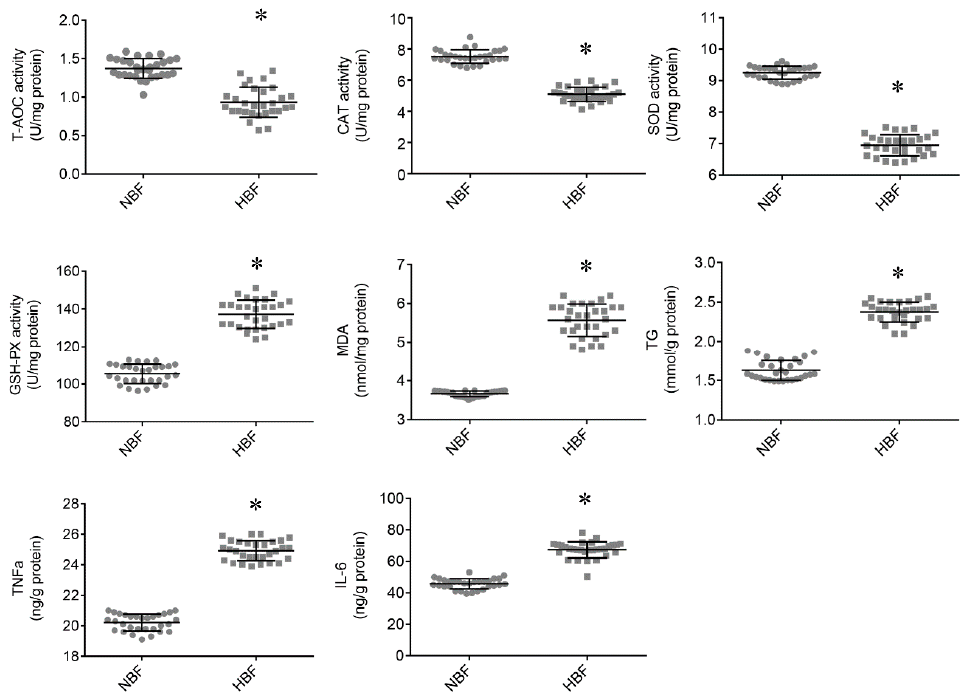
Figure 1. Antioxidant status, TG and inflammatory markers of full-term placentas. Abbreviations: SOD, superoxide dismutase; CAT, catalase; GSH-PX, glutathione peroxidase; T-AOC, total antioxidant capacity; MDA, malondialdehyde; TG, triglyceride. n = 30 biological replicates in each group. Values are presented as means ± SEM. * p <